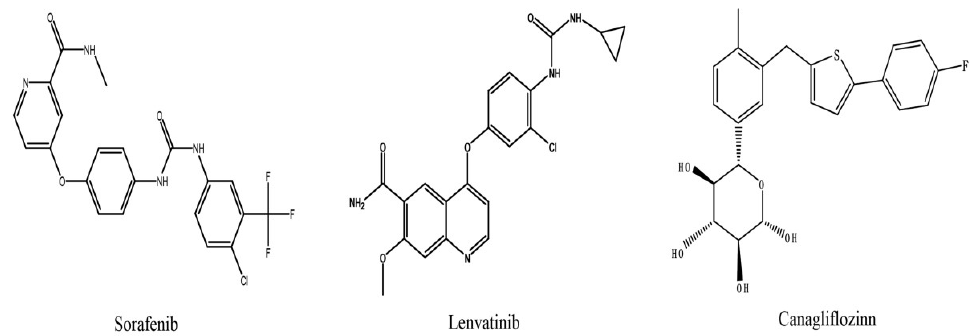
Figure 1. The structure of sorafenib, lenvatinib, and canagliflozin.